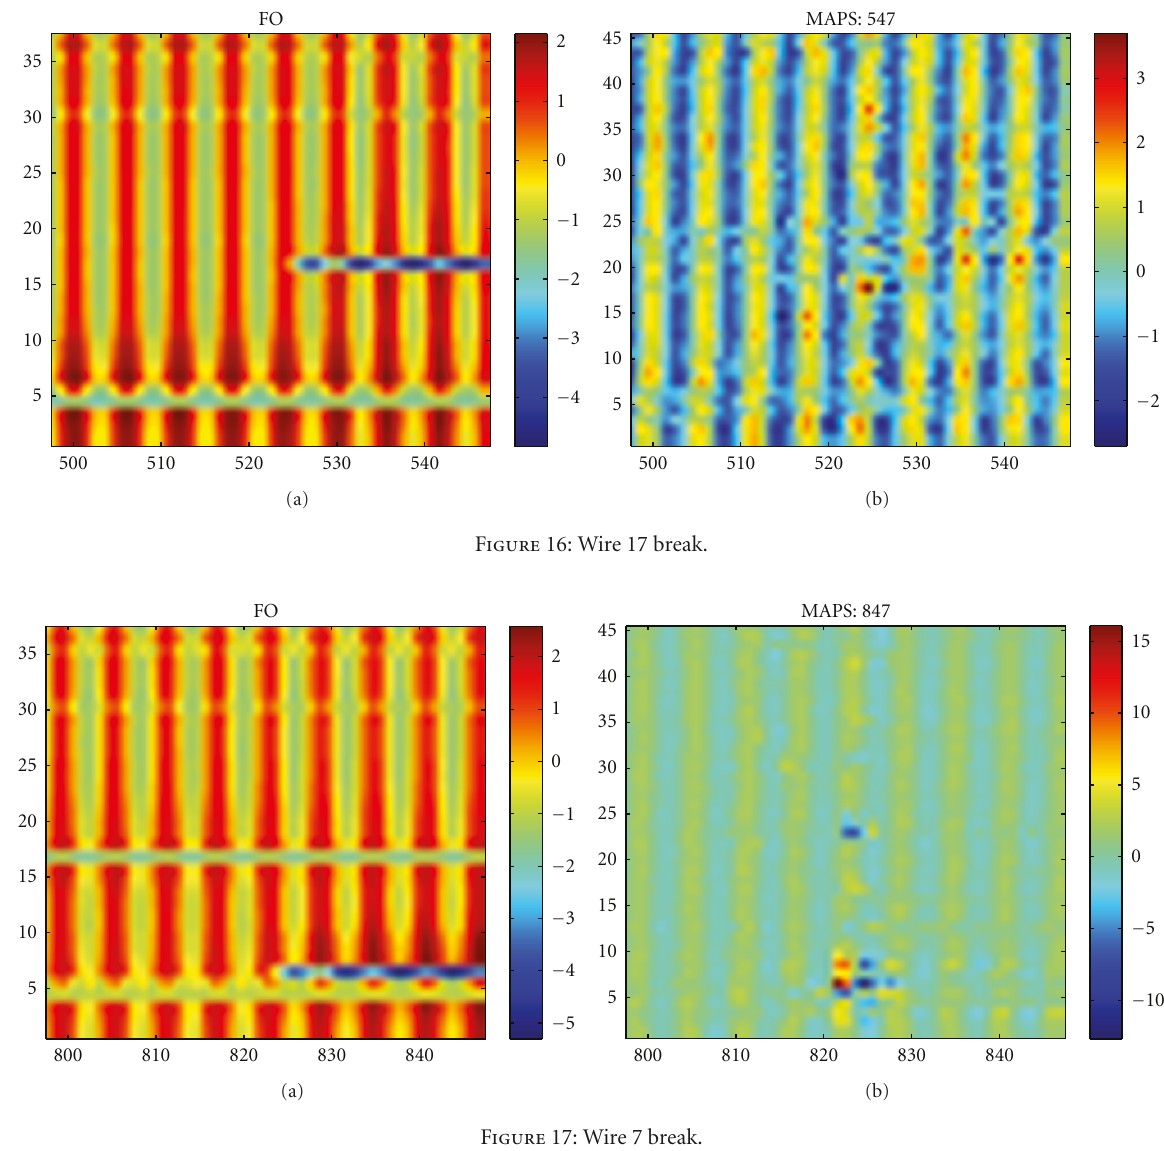
Figure 17: Wire 7